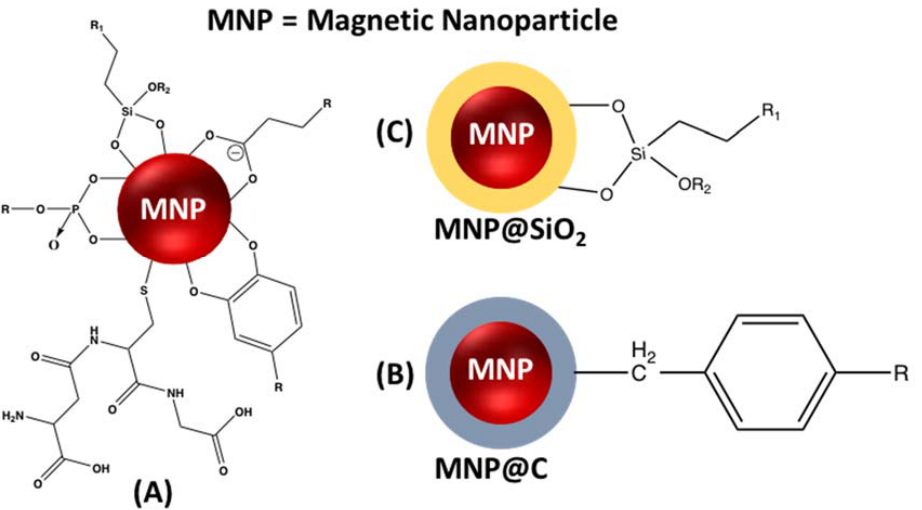
Figure 11. Different approaches to functionalize magnetic nanoparticles (MNPs): ( A ) iron oxide MNPs; ( B ) silica ‐ coated MNPs; and ( C ) carbon ‐ coated MNPs [63] (Adapted with permission from The Royal Society of Chemistry).